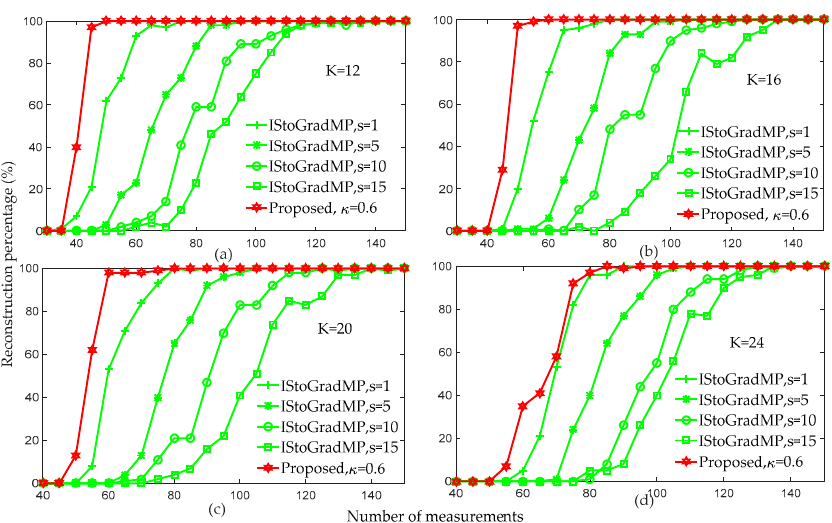
Figure 8. Reconstruction percentages of the proposed algorithm and IStoGradMP algorithm ( n = 256, κ = 0.6, K = 12,16,20,24, s = 1,5,10,15, m = 30 : 5 : 150, Gaussian signal).